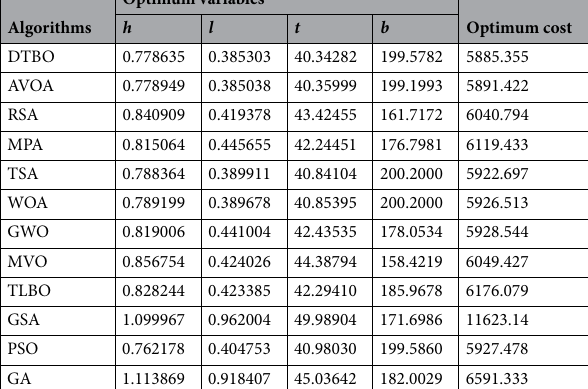
Table 8. Performance of optimization algorithms in pressure vessel design.